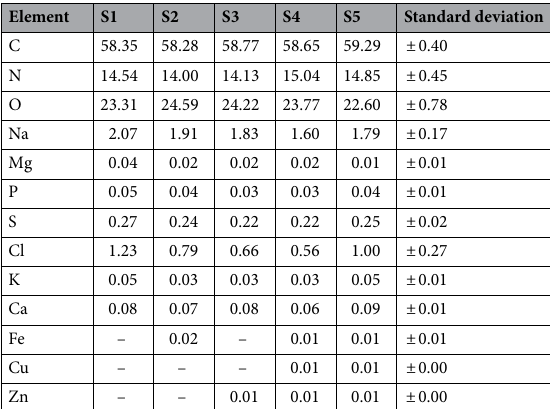
Table 5. Elemental composition of AAF.